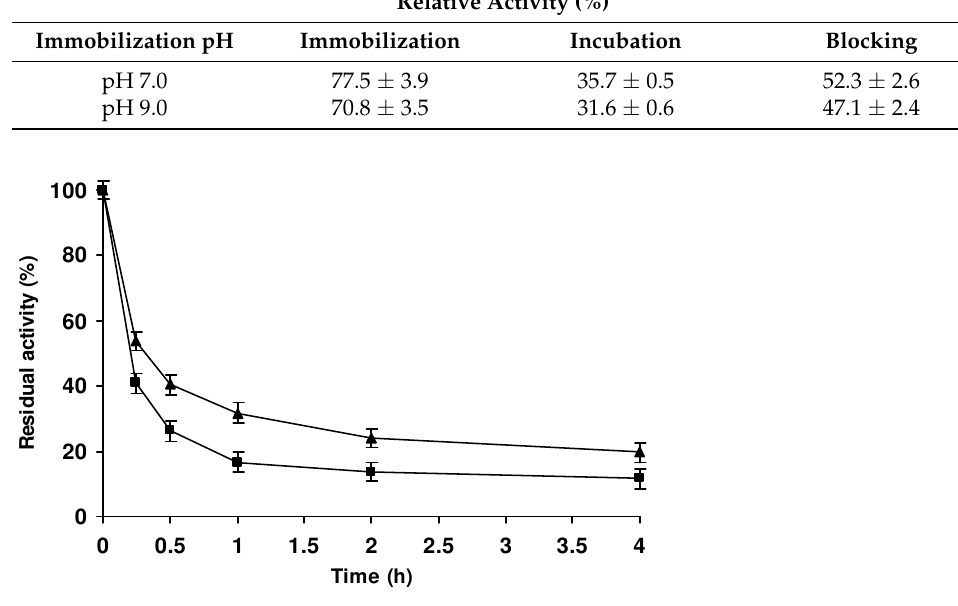
Table 3. Effect of the incubation pH in the relative hydrolytic activity of PGA. Immobilization was performed in 5 mM of sodium phosphate at pH 7.0. Incubation was carried out using 25 mM of sodium phosphate at pH 7.0 and 8.0 or sodium carbonate at pH 9.0 and 10.0 (an additional 100 mM of phenylacetic acid and 30% glycerol were always added) for 3 h. Blocking was performed using 2